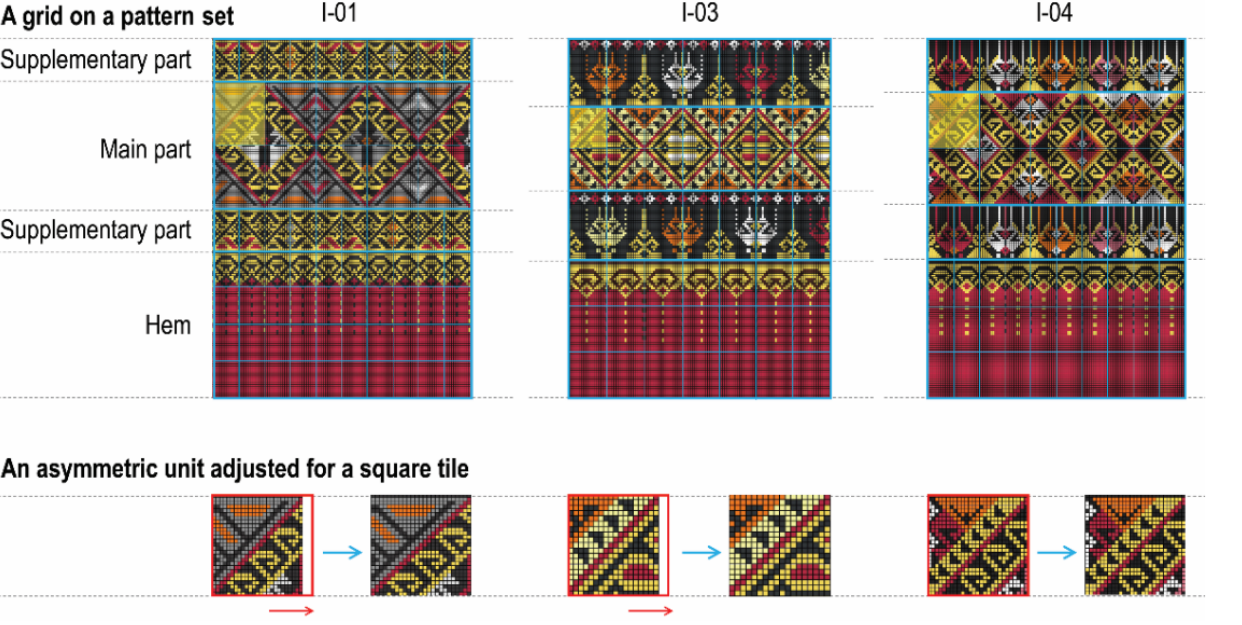
Figure 8. Asymmetric units from three main parts and adjustments on square tiles. Red arrows indicate stretching in a horizontal orientation. Blue arrows indicate the unit adjustments or compliance to the square. (Illustration by Kunkhet and Chudasri).